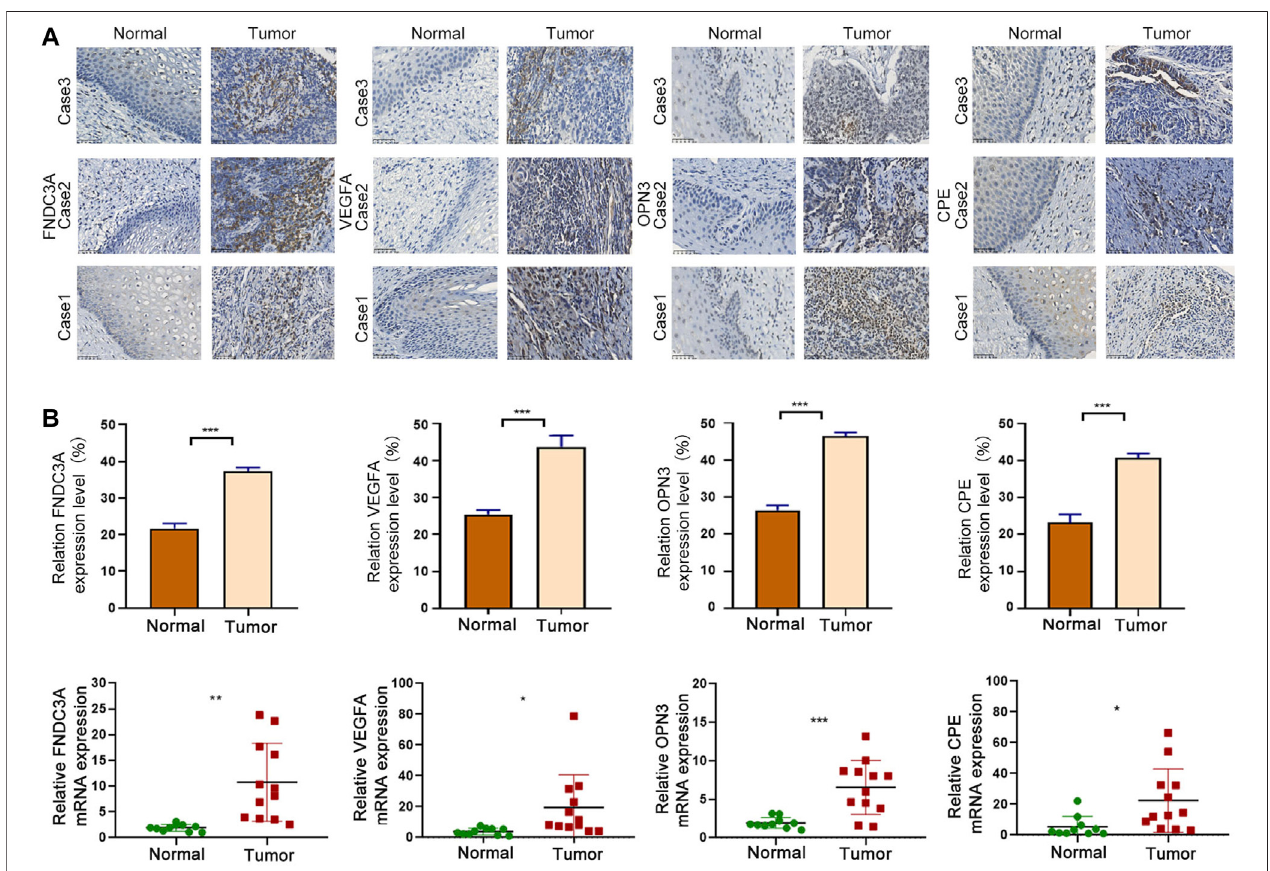
FIGURE 10 | Signature gene expression was upregulated in CC. (A) IHC analysis of FNDC3A, VEGFA, OPN3 and CPE protein levels in tumor and normal tissues. Scale bar (cid:1) 50 μ m *** p < 0.001. (B) qRT-PCR analysis of FNDC3A, VEGFA, OPN3 and CPE mRNA levels in tumor and normal tissues. *, p < 0.05. **, p < 0.01. ***, p <